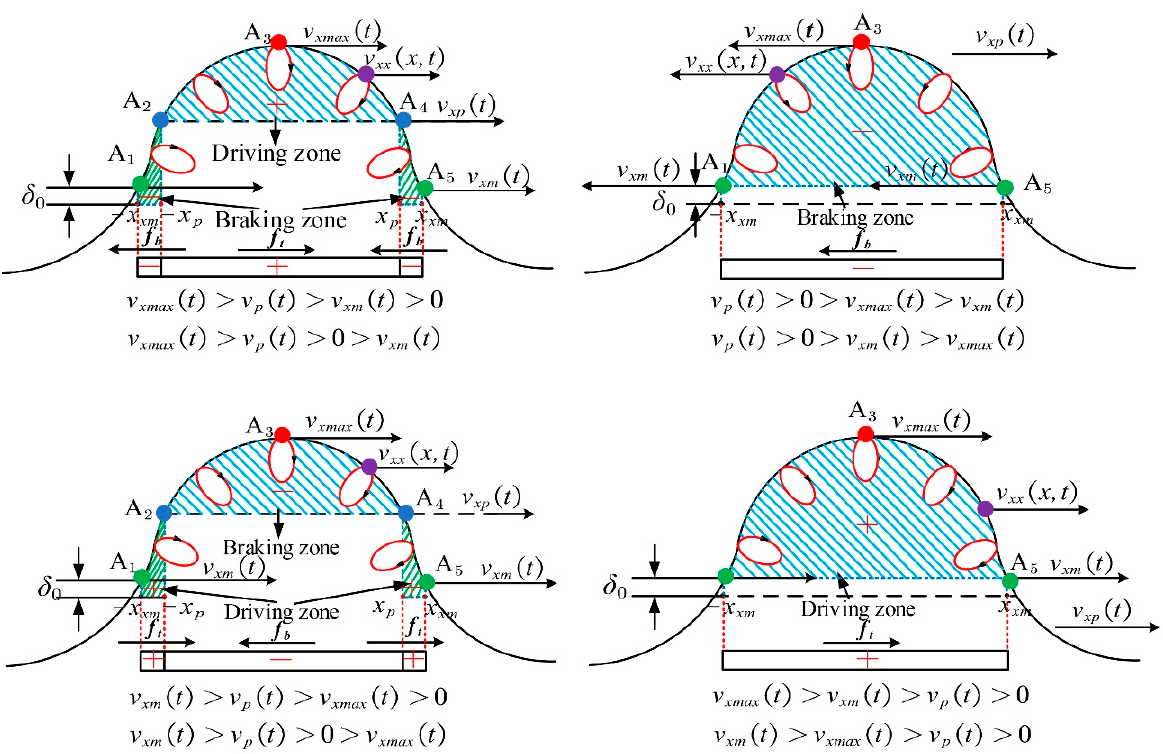
Figure 7. Forward nonsliding point transfer model. culation results of the formulas, sign of the crest contact point are greater than the tangential velocity, v xp ( t ) , of the nonsliding point, this region is the driving zone (the area of the plus sign), and vice versa is the braking zone (the area of the minus